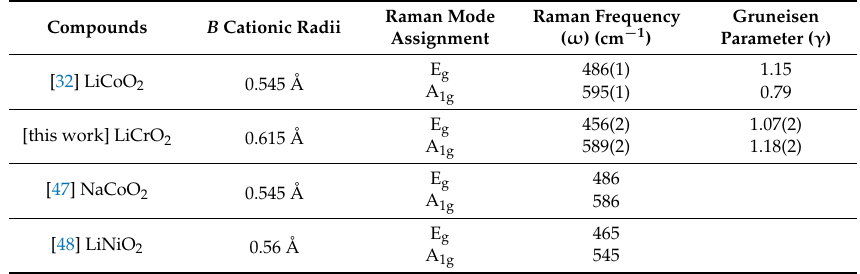
Table 2. Experimental Raman modes along with Gruneisen parameters ( γ ) for a LiCrO 2 and isomorphic